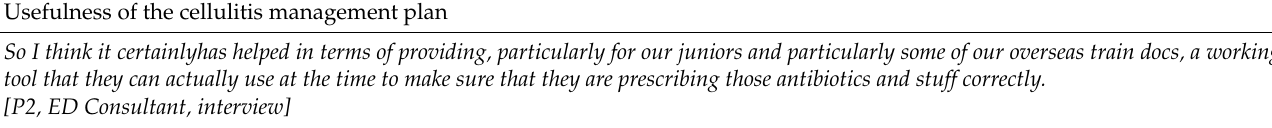
Table 5. Quotes from the key informant interviews grouped into